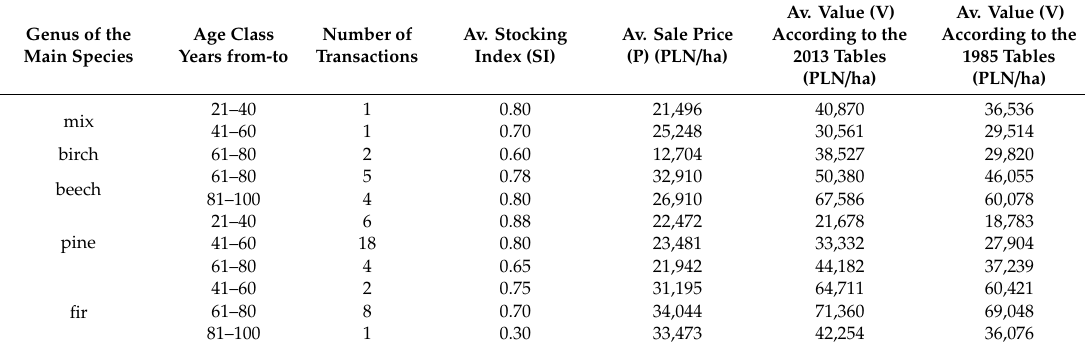
Table 2. Descriptive statistics of forest property by dominant tree species in the